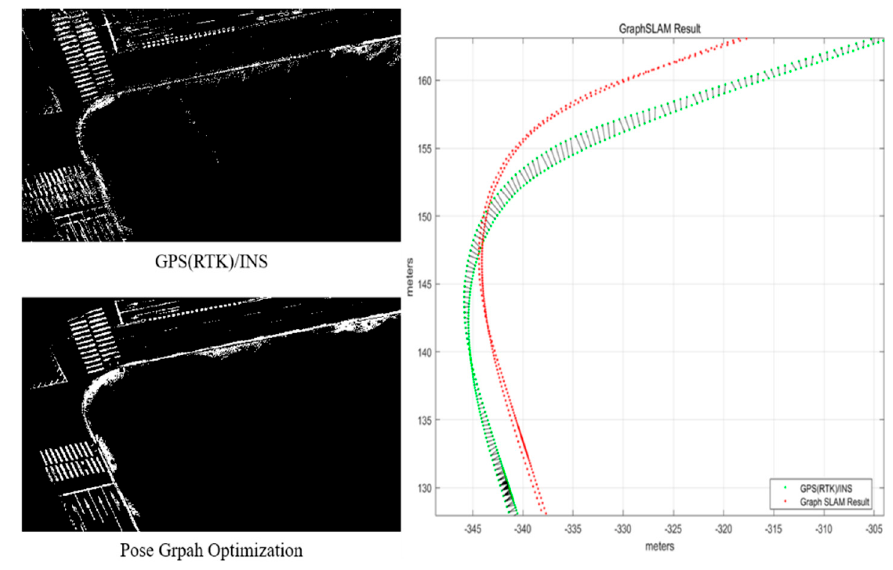
Figure 5. Result of pose graph optimization.